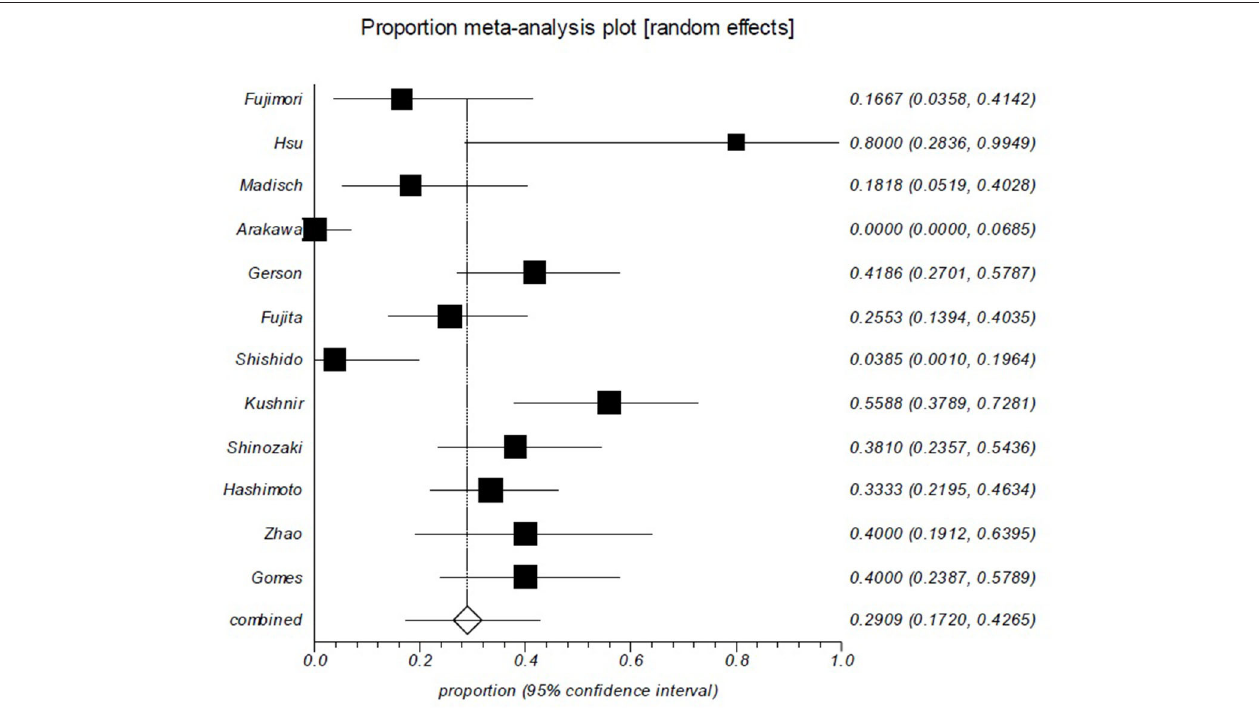
FIGURE 2 | Rebleeding rate after negative balloon-assisted enteroscopy (BAE) is ∼ 29%. Rebleeding in patients after negative BAE for obscure gastrointestinal bleeding (OGIB). Rebleeding episodes during the follow-up period were reported in 29.1% (95% CI: 17.2–42.6%) of the 407 patients in the 12 studies. There was significant heterogeneity among the studies ( p < 0.0001).